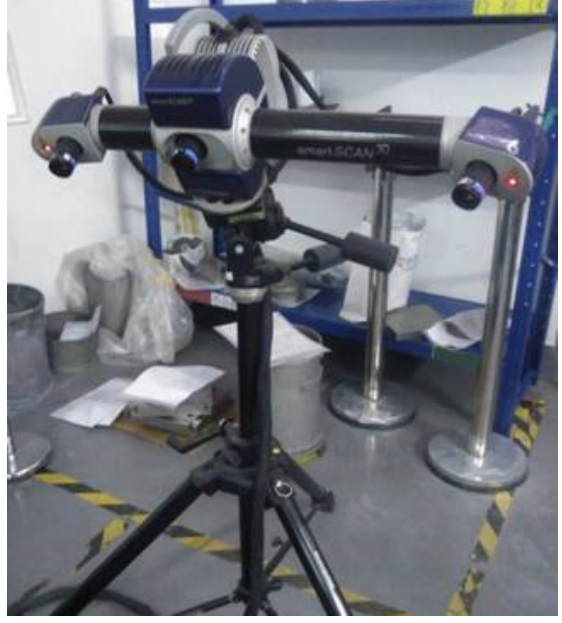
Figure 2. Breuckmann SmartSCAN3D scanner for the warpage measurements.